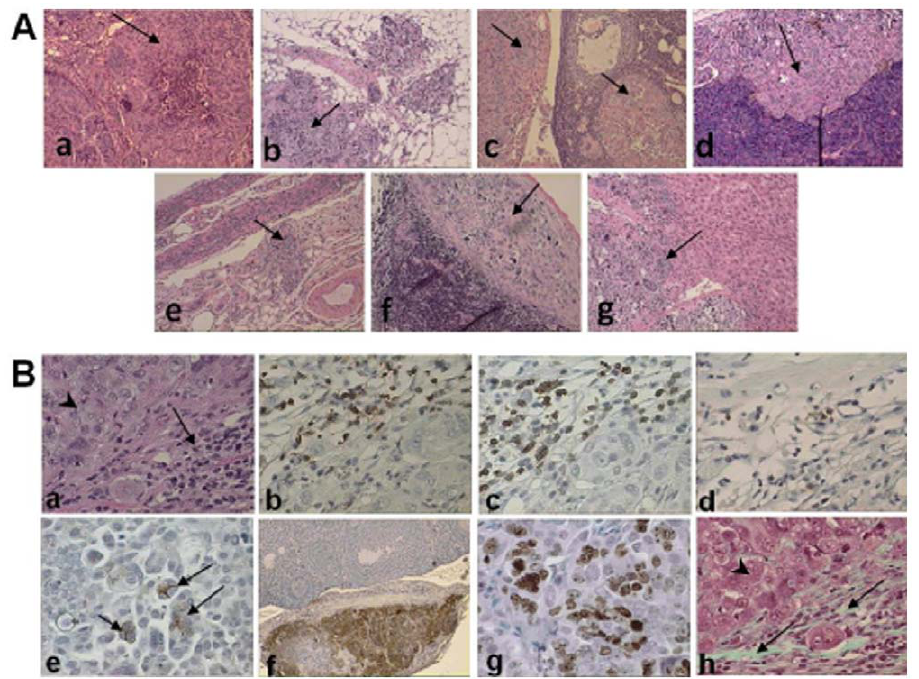
Figure 3. Tumor and stroma in multiple organs in NSG mice following injection of tumor aggregates. H&E staining shows evidence of tumor (see arrows) in peritoneal nodule from omentum (Aa and Ab), ovary and periovarian fat (Ac), pancreas (Ad), uterus (Ae), spleen (Af), and liver (Ag). These tumors resulted from the i.p. injection of tumor-derived cell aggregates derived from a papillary serous carcinoma of the ovary. Mice were sacrificed 140 days post inoculation. Lymphocytes (arrow) were observed in juxtaposition with tumor cell (arrowhead) (Ba). Immunohistochemical staining (B) shows the presence of human CD45 + leukocytes (Bb), CD3 + T cells (Bc), CD20 + B cells (Bd), CD138 + plasma cells (Be), and HLA + tumor nodule adjacent to the ovary (Bf). Proliferation of tumor cells is shown by positive stain with KI67 (Bg), and evidence of stromal fibroblasts illustrated by trichrome staining of collagen see arrows (Bh). Arrow head shows tumor cells. All sections in A are at 100 6 magnification and in B the sections are at 400 6